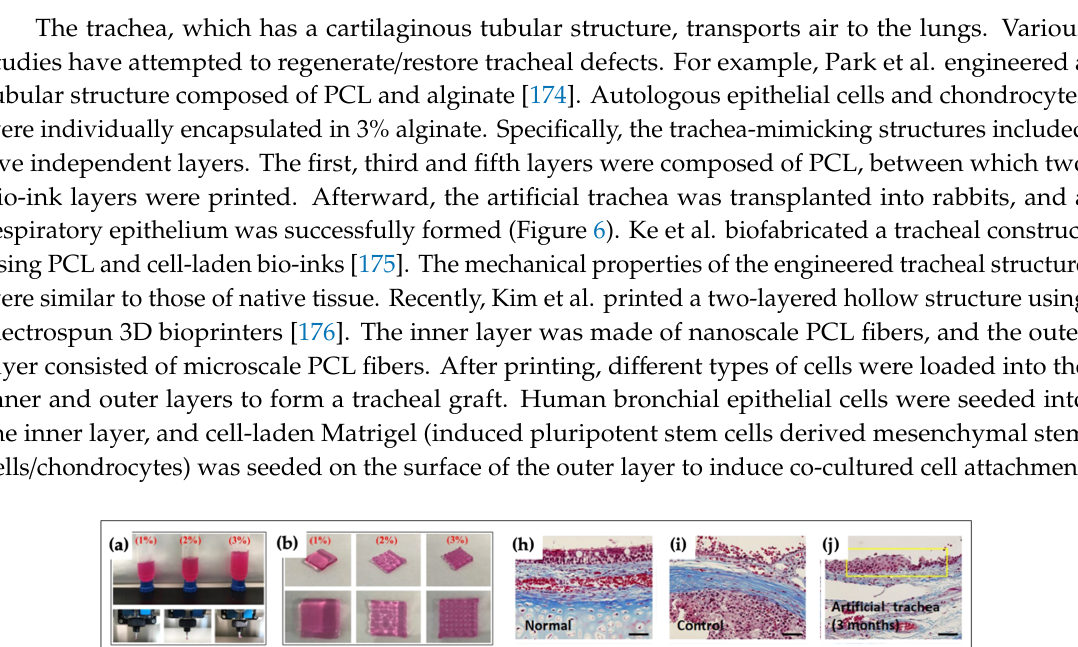
(green), chondrocytes (red) and merged image; ( h ) normal tracheal epithelium; ( i ) control